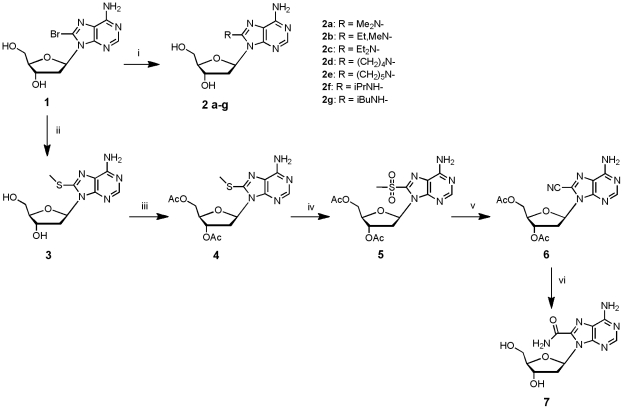
Synthesis of 8-modified nucleoside analogues 2a–g, 3 and 7.(i) Primary amine, MeOH, 65°C, 24 h or secondary amine, MeOH, room temperature, 24 h; (ii) MeSNa 25%/H2O, DMF, room temperature, 3 h; (iii) Ac2O, pyridine, room temperature, 5 h; (iv) KMnO4, CH3CO2H/H2O (50/50 v/v), 0°C, 1 h; (v) NaCN, DMF, room temperature, 3 h; (vi) NaOH 1 M, H2O, room temperature, 7 h.